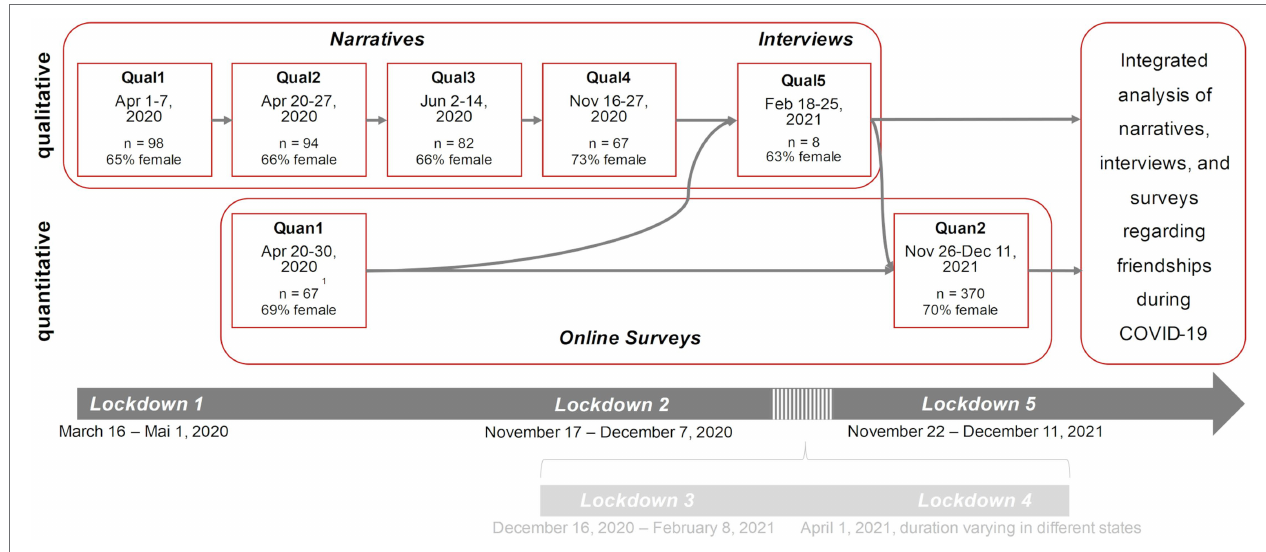
FIGURE 1 | Study design. Qual = data collection for the qualitative study, Quan = data collection for the quantitative study. 1 repeated measure